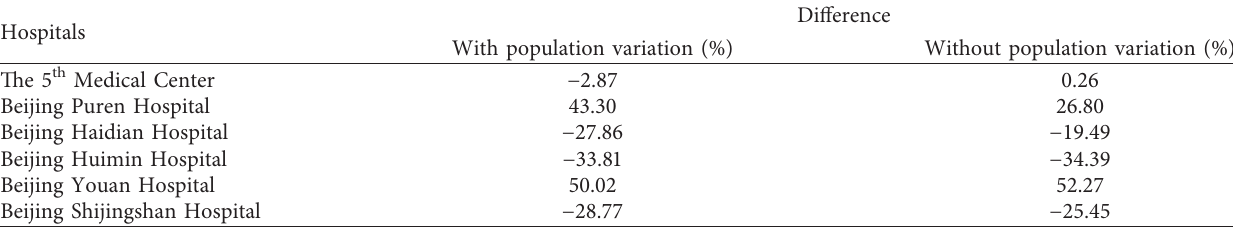
Table 5: Accessibility difference of the designated